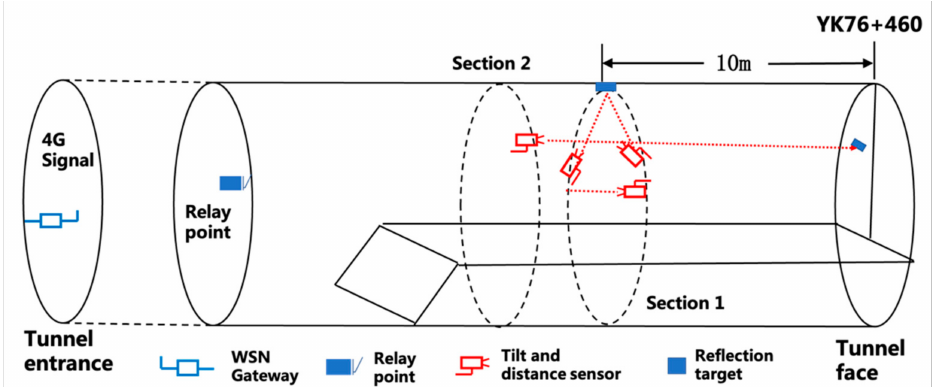
Figure 9. Longitudinal schematic diagram of the sensor layout in each